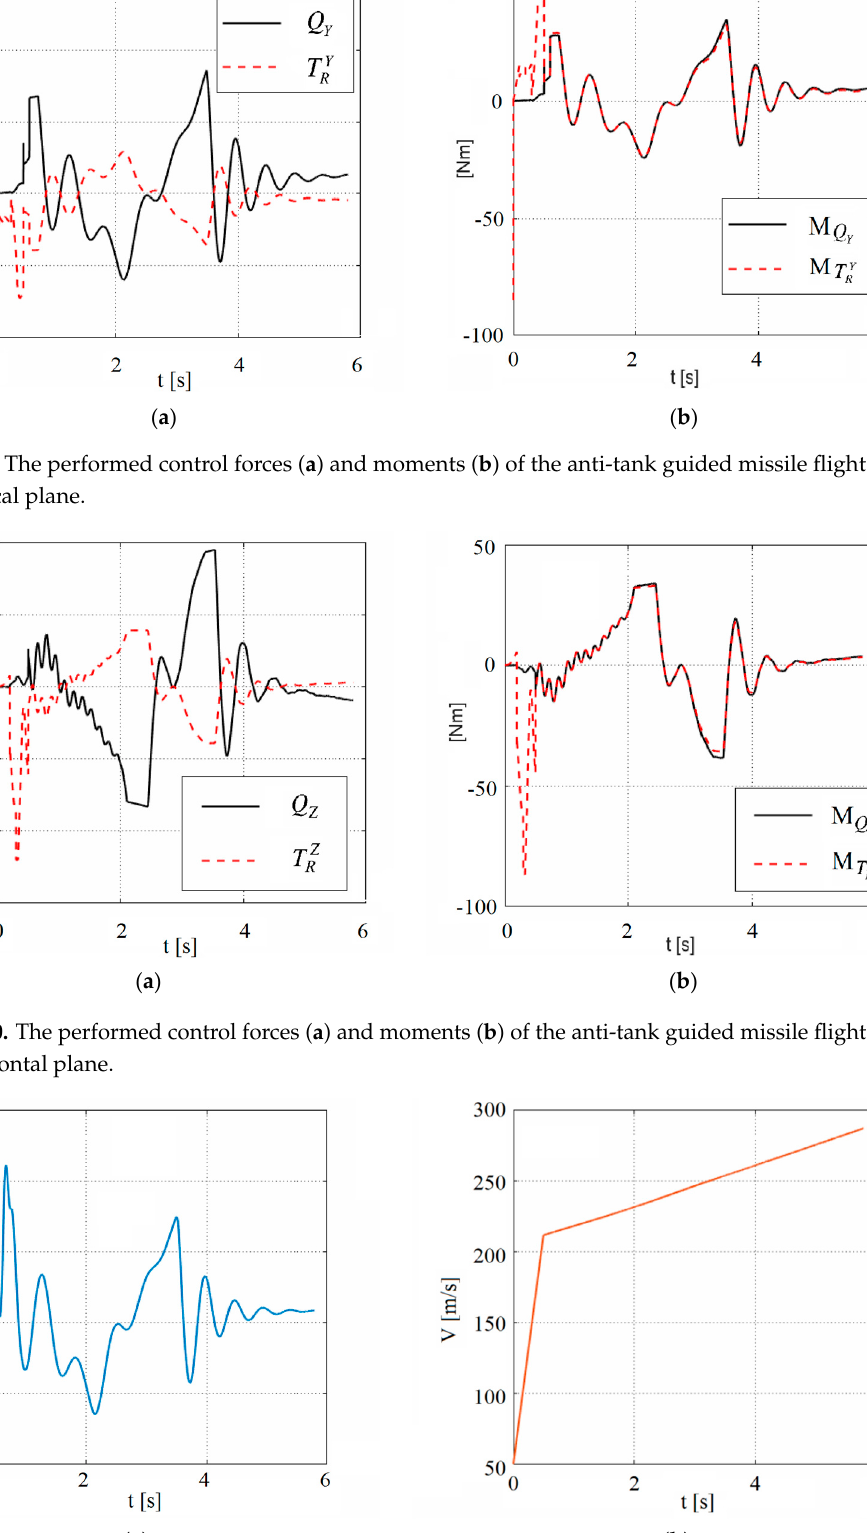
Figure 11. Implemented angle of attack α ( a ) and velocity of the ATGM ( b ) in function of time.